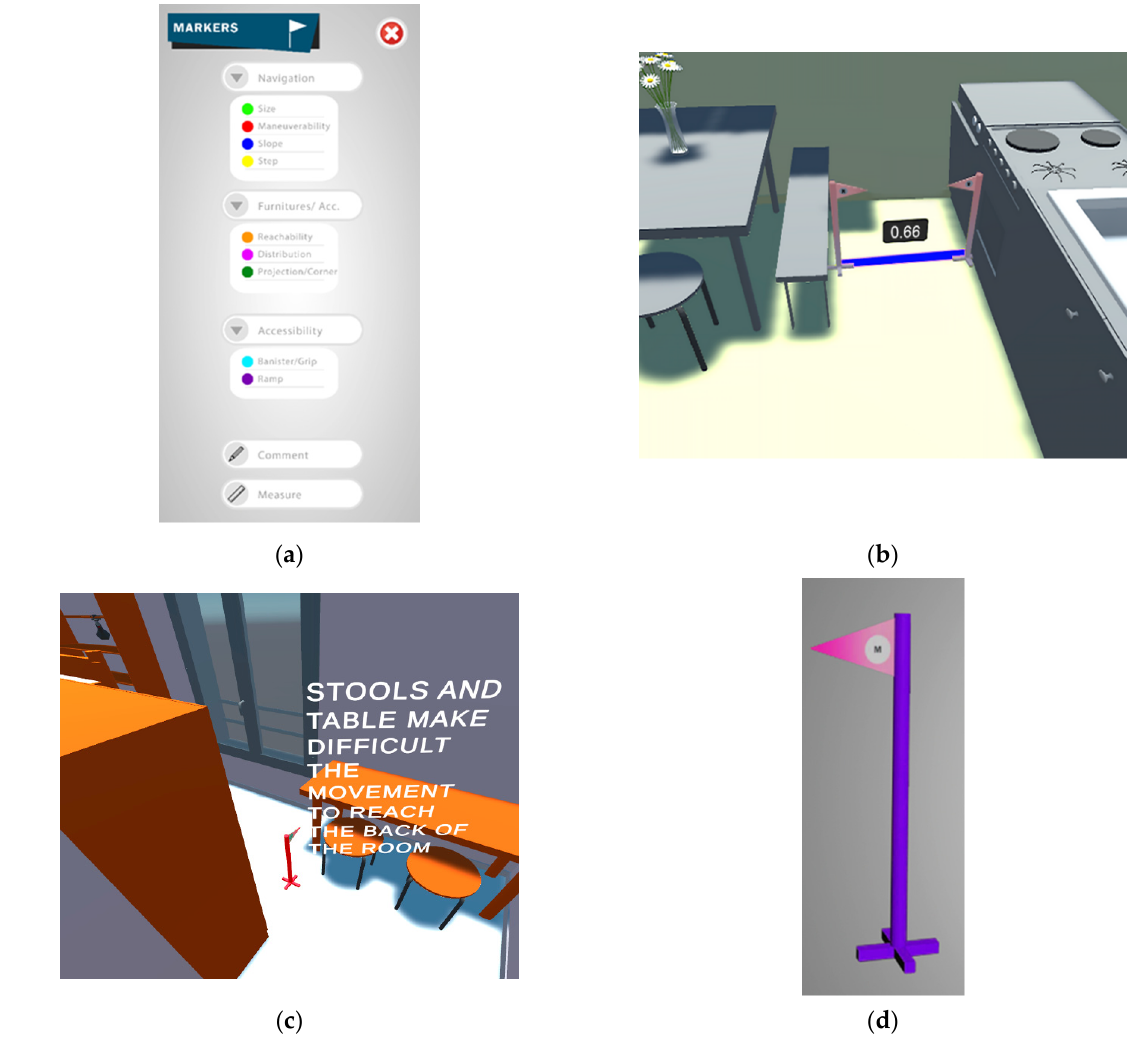
Figure 7. ( a ) Types of MarkersUI. ( b ) Example of a measure marker. ( c ) Example of a marker comment. ( d ) Shape that was used to identify the distribution marker at the scene.